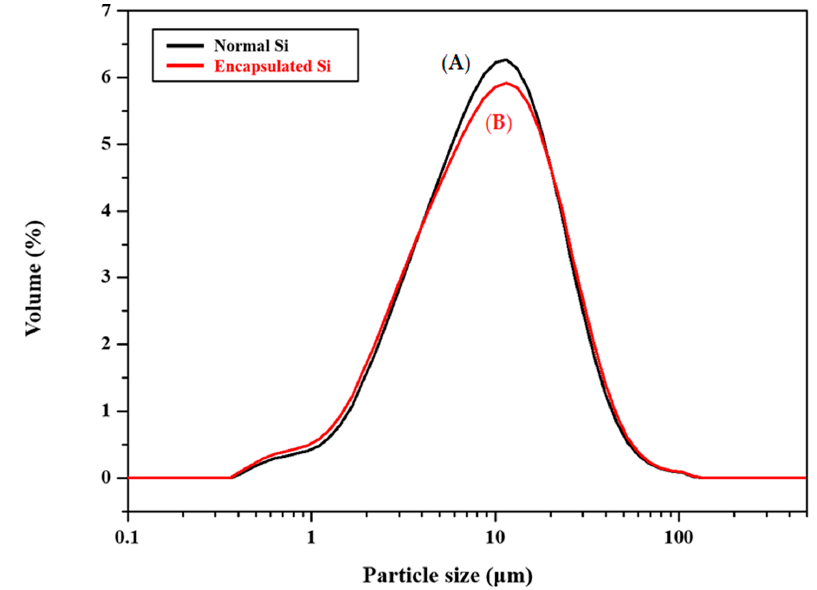
Figure 5. The particle size distribution of ( A ) normal Si, and ( B ) Si powder encapsulated by a binary system.